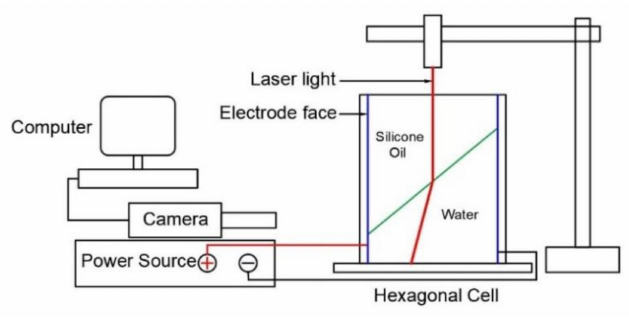
Figure 7. Experiment setup.